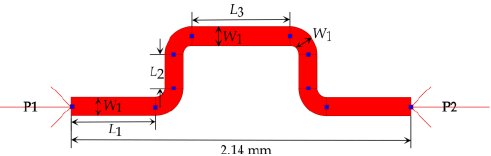
Figure 12. Layout of a microstrip phase shifter in ADS.